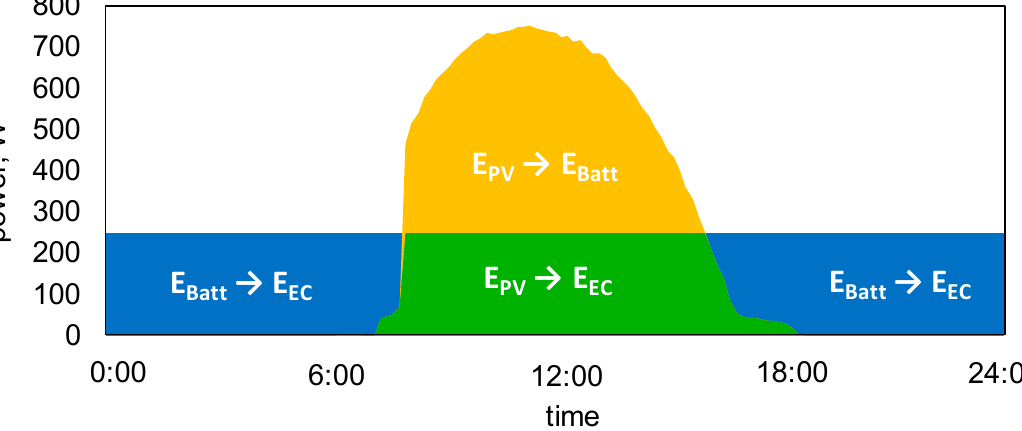
Figure 16. The energy distribution during a daily cycle in the proposed energy storage system.